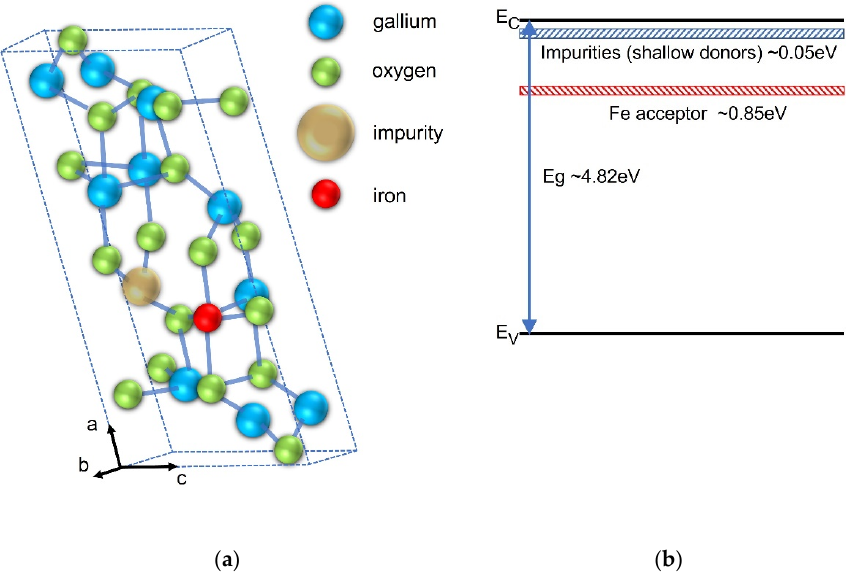
Figure 1. ( a ) The unit cell of monoclinic β -Ga 2 O 3 together with the possible locations of the impurity and Fe ion. The impurities work as shallow donors and provide free electrons nearby, and the Fe works as an acceptor and captures the thermally excited electron. ( b ) Energy band diagram for β -Ga 2 O 3 with the shallow impurities and Fe acceptors.